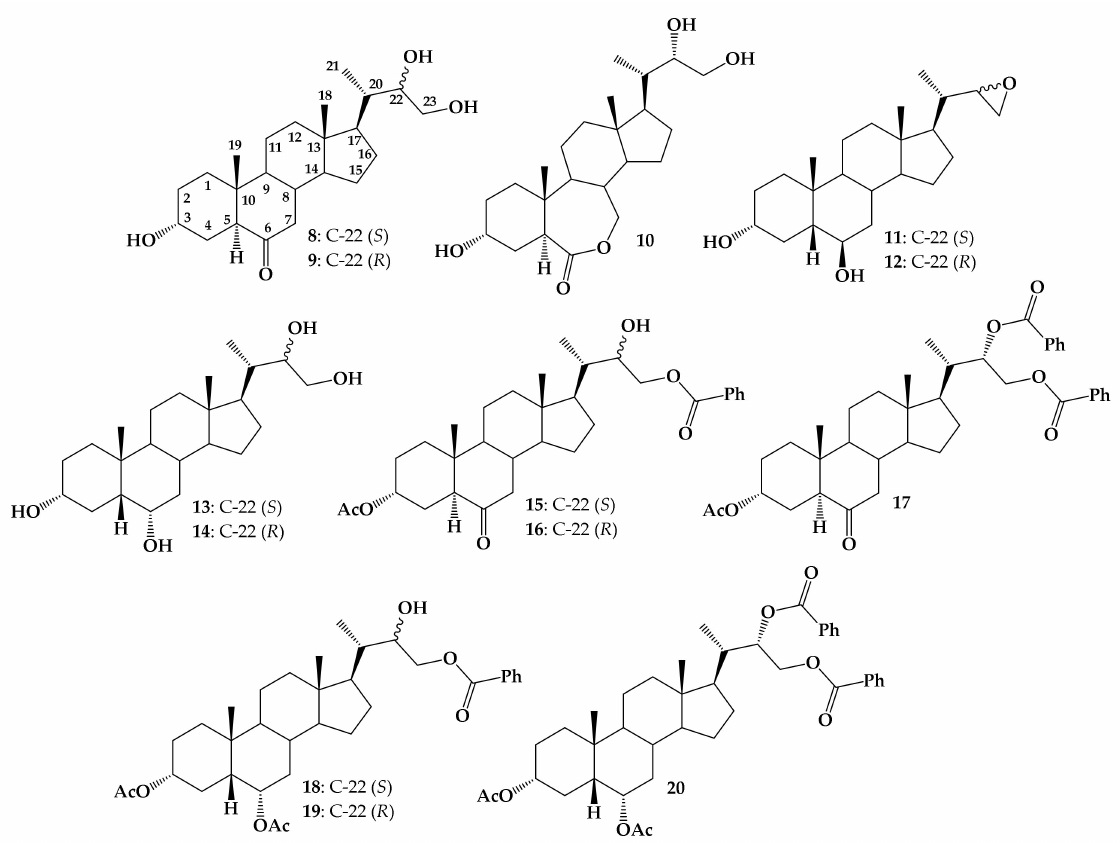
Figure 2. Structure of synthetic BRs 24-norcholan type 8 – 14 and 24-norcholan type 15 – 20 benzoylated